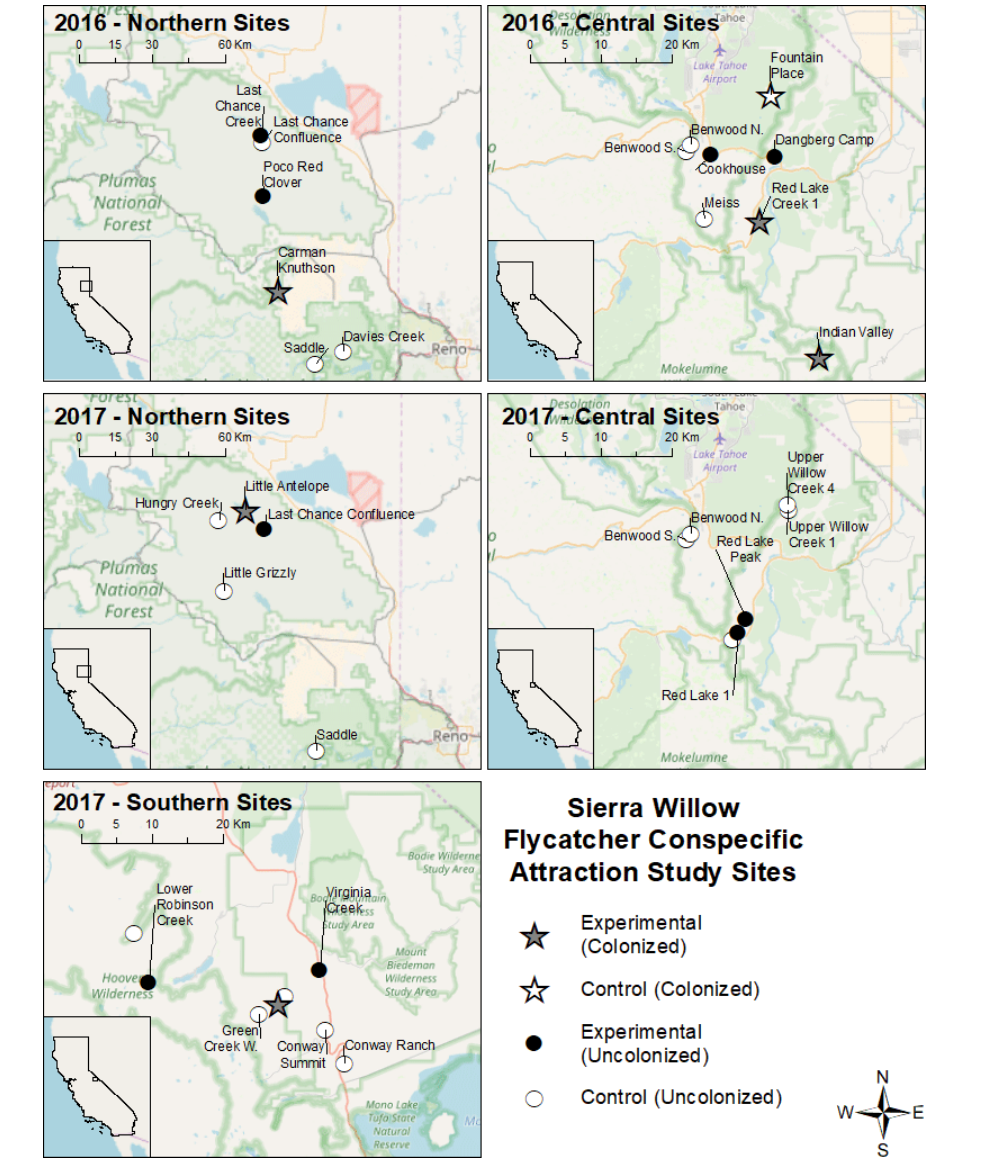
Fig. 1 . Locations of all meadows used as control (black) or experimental sites (white) during the 2016 and 2017 Willow Flycatcher ( Empidonax traillii ) breeding season in the Sierra Nevada, California. Stars indicate sites where Willow Flycatchers were detected displaying territorial or nesting behaviors between 15 June and 15 July. All 2016 study meadows shown were also resurveyed during the 2017 breeding